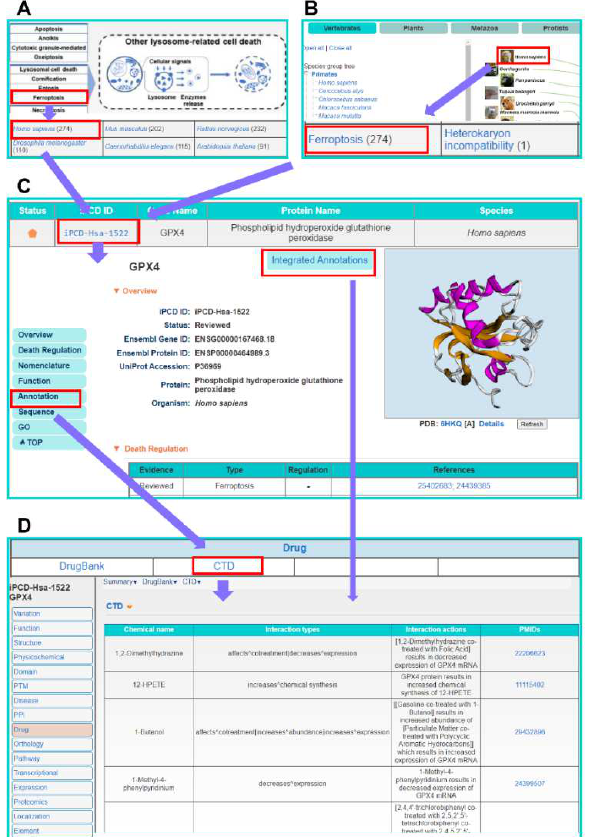
Figure 4. The usage of browse options in the iPCD. ( A ) Browse by process. ( B ) Browse by species. ( C ) The basic information page of human GPX4. Additional annotations could be viewed by clicking the ‘Annotation’ or ‘Integrated Annotations’. ( D ) The additional annotations page of human GPX4 covered 16 aspects. The detailed PTM information of PLMD about GPX4 is shown.